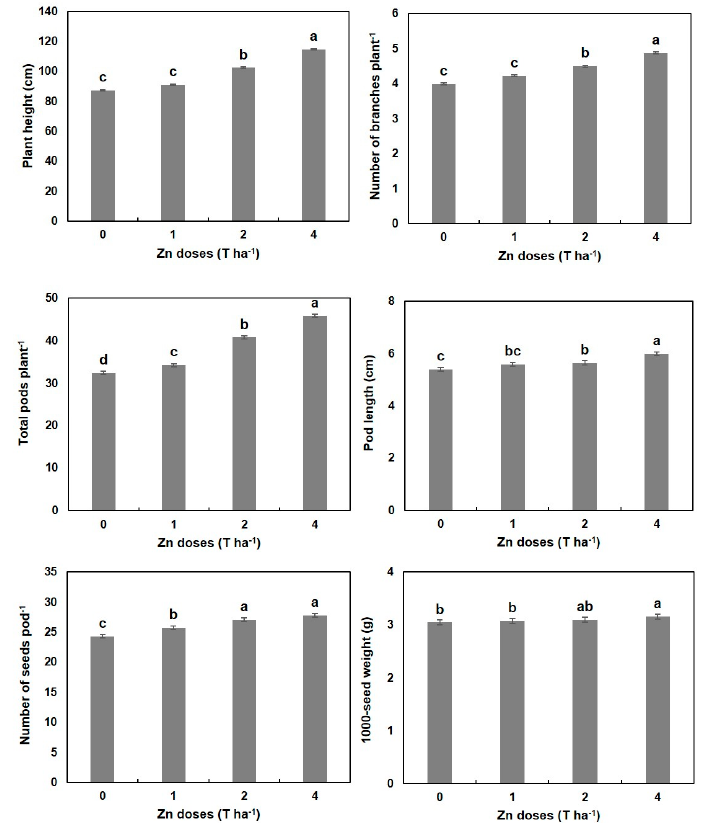
Figure 1. Zn’s impact on plant height, branches plant − 1 , pods plant − 1 , pod length, seeds pods − 1 and 1000-seed weight of Mustard. Figures with same letter (s) do not differ significantly, whereas figures with dissimilar letters differ significantly as per DMRT.